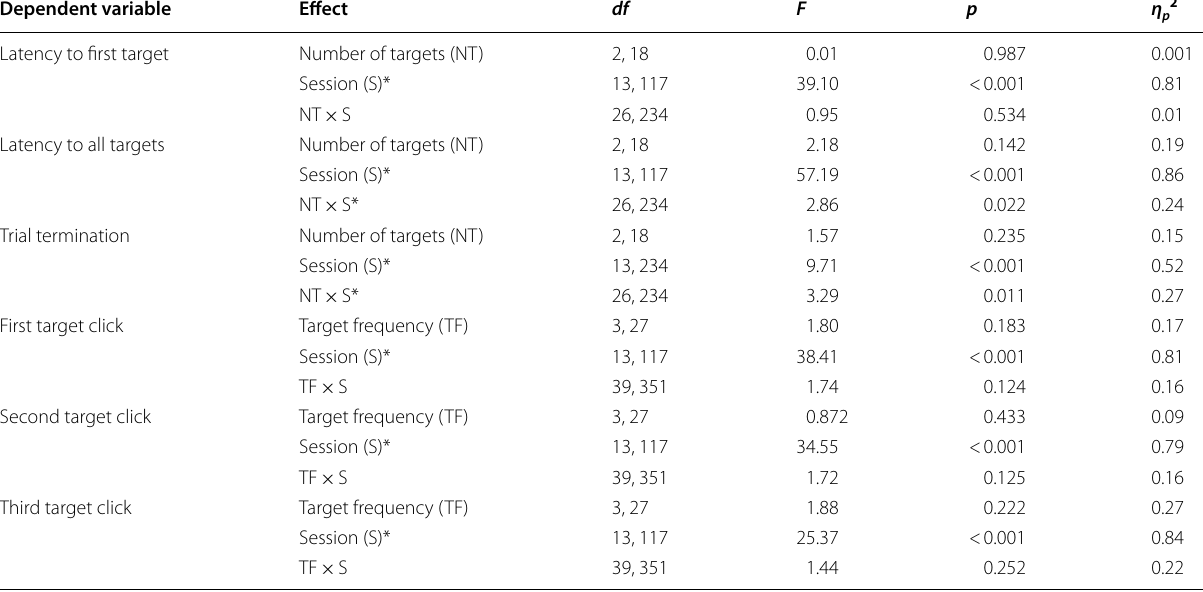
Table 2 Results of analyses on multiple percentage change RT measures